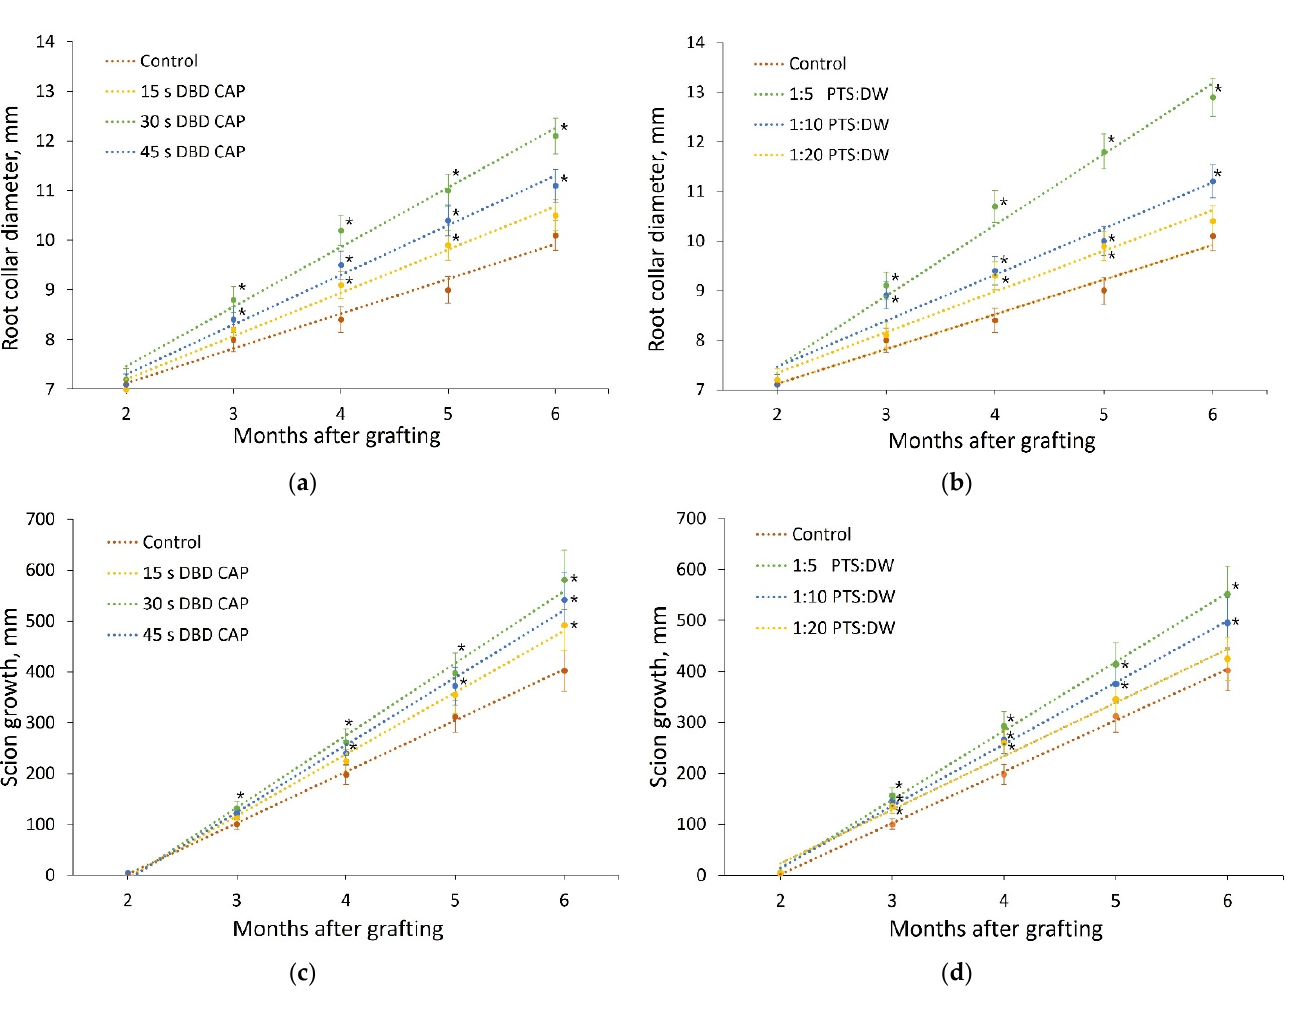
Figure 7. Development of pear shoots within 4 months after planting in a greenhouse at an air temperature of (35 ± 1) °C. The results of the root collar diameter ( a , b ) and the scion growth ( c , d ) measurements are presented for 7 experimental groups: control, direct treatment with various DBD CAP exposure durations (15 s, 30 s, and 45 s), and indirect treatment with PTS diluted in DW in three proportions (1:5, 1:10, and 1:20). Number of samples in each experimental group is presented in Table 1, and number of measurement repetitions was 5. * indicates a significant difference at 5% level in comparison with the control ( p < 0.05, ANOVA). Data are presented as mean values and standard errors of the mean.